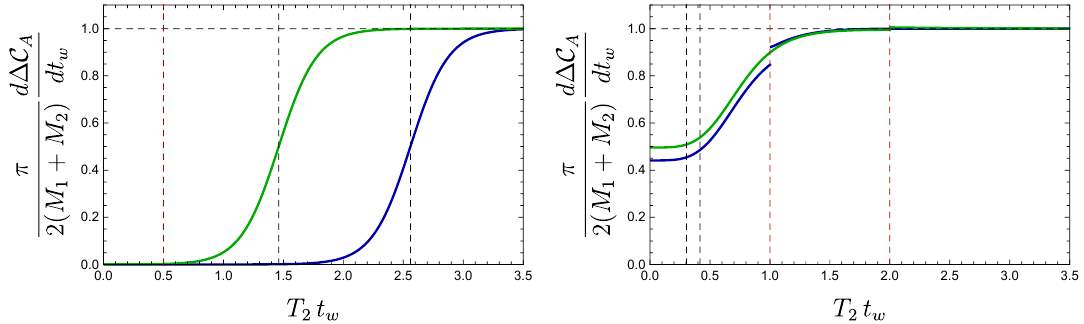
Figure 32. The derivative of the complexity of formation with respect to the insertion time t planar AdS 5 . In the left panel, we evaluate for a light shock waves with w = 1 + 10 (cid:0) 6 (blue) and w = 1 + 10 (cid:0) 3 (green), while in the right panel, we have heavier shock waves with w = 2 (blue) and w = 4 (green). The results for light shock waves resemble those for the BTZ black hole in (cid:12)gure 8, with a clear transition between two regimes at the scrambling time, indicated by the vertical dashed black lines. For the heavier shock waves, even though the complexity is a continuous function of t w as the regime makes a transition between regimes ( a ) and ( b ), as in eqs. (B.22) and (B.23), the derivative has a non-zero jump proportional to log w , as shown in eq. (B.32). The vertical dashed black line denotes the transition from regimes ( a ) to ( b ), while the dashed red line stands for the delay time in eq. (B.28). Notice that for heavy shock waves, there is a longer period with a constant derivative, in contrast to the BTZ result in (cid:12)gure 8. The pro(cid:12)le for heavier shock waves is very similar to the w = 4